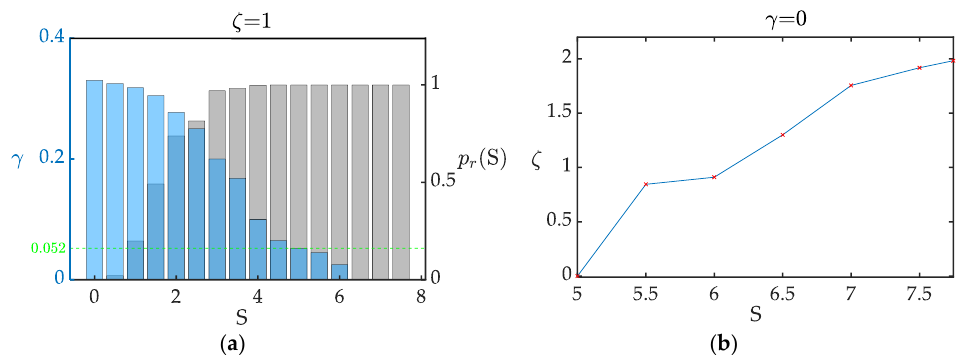
Figure 14. The marginal evaluation results for designed mission profile ( a ) Trend of exclusion ratio and confidence level against cost function at a different stage of design parameter optimization is plotted at ζ = 1; ( b ) Achievable marginal requirement.